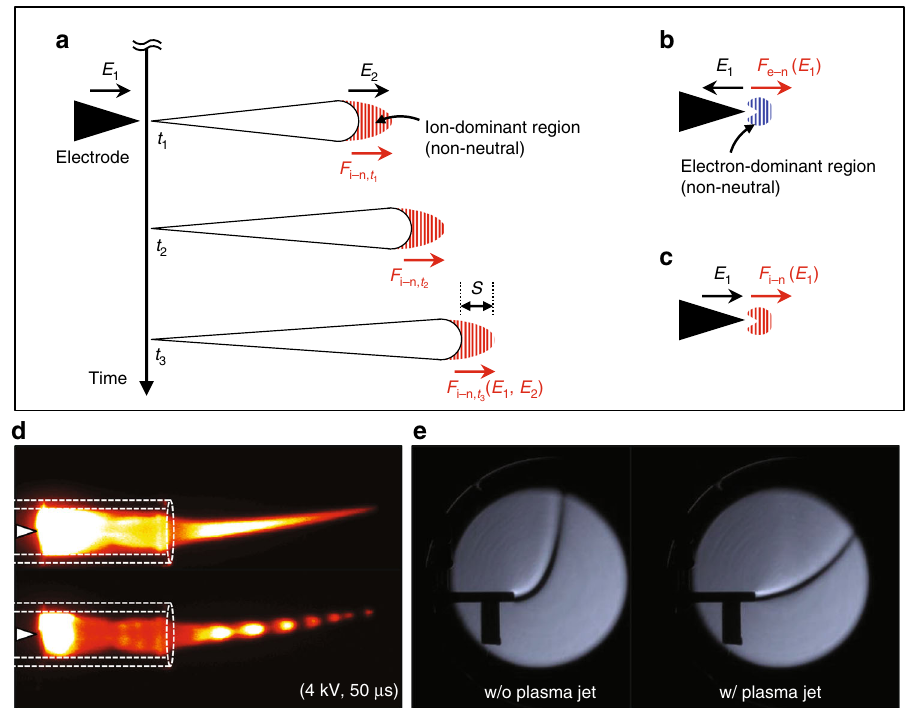
Fig. 1 A simple illustration of EHD force generation via different mechanisms. The schematic of EHD force generation by a positive pulsed streamer propagation driven by (positive) ion and the presented space charges behind the moving front, where E 1 and E 2 represent external and internal electrical fi elds, respectively. The cases of EHD force generation by b electron drift in negatively pulsed plasma jets or c ion drift in positively pulsed plasma jets are presented. d A plasma jet image in continuous mode and composite image of nanosecond-resolved images are presented along with a schematic of the experiment with the glass tubing and electrode. e The jet of free gas fl ow without plasma has a fl ow trajectory or free jet boundary, which is imaged by Schlieren photography, and this trajectory changes when the plasma discharge is turned on, thereby providing information on the fl ow parameters. The glass tubes with an inner diameter of 3.5 mm are used as substitute for scale bars for all